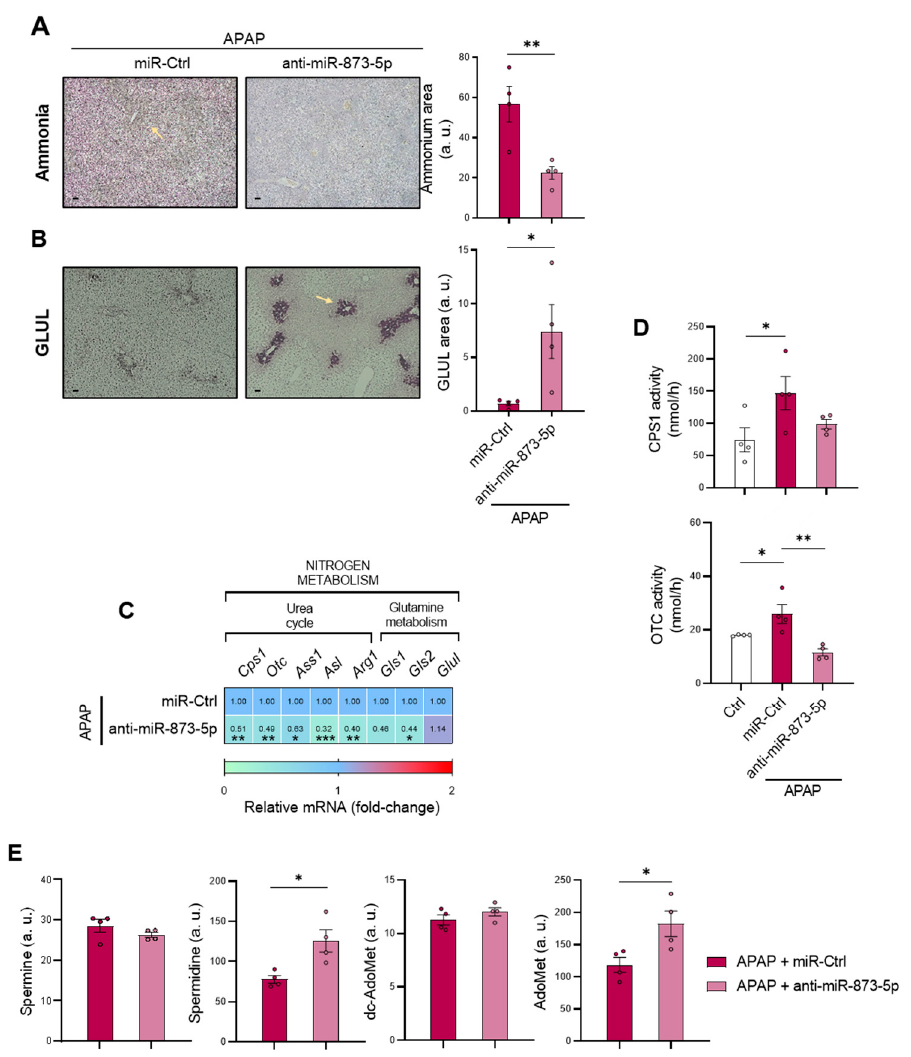
Figure 5. Nitrogen homeostasis, S-adenosylmethionine and polyamines are restored by targeting miR-873-5p. Representative micrographs and respective quantification of ( A ) hepatic ammonia and ( B ) glutamine synthetase (GLUL) staining (highlighted with yellow arrows); ( C ) relative hepatic mRNA expression of urea cycle and glutamine metabolism genes; ( D ) relative hepatic activity of carbamoylphosphate-synthase 1 (CPS1) and ornithine transcarbamilase (OTC) and ( E ) determination of hepatic S-adenosylmethionine (AdoMet), decarboxy-S-adenosylmethionine (dc-AdoMet), spermine (Spm) and spermidine (Spd) in mice administered acetaminophen (APAP) for 48 h and treated with either an anti-miR-873-5p or miR-Ctrl. Scale bar corresponds to 50 μ m. * p < 0.05, ** p < 0.01 and *** p < 0.001 are shown. (See also Supplementary Figure S5.).